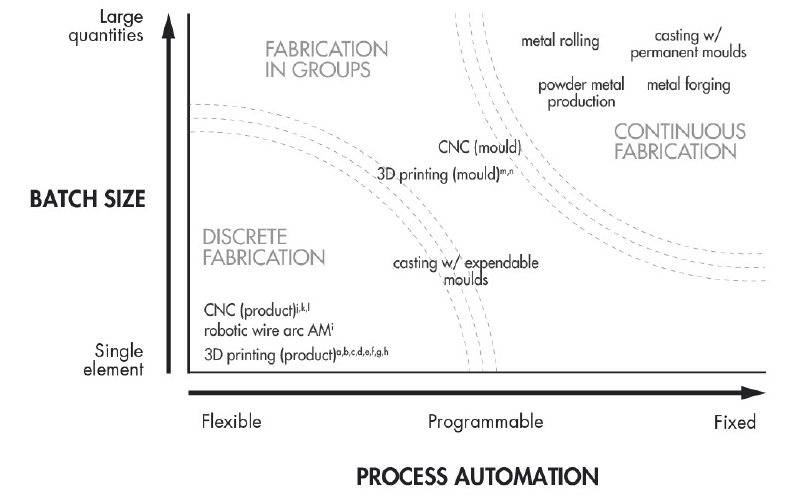
Figure 2. Classification of joint fabrication processes depending on batch size and process automation, and literature examples for each (adapted form [6]). The boundaries between different fabrication types remain fluid and cannot be strictly defined. (a) Hubs [36], (b) Chun et al. 2018 [37], (c) Dritsas et al. 2017 [38], (d) Souza et al., 2018 [39], (e) Tanadini et al., 2022 [40], (f) Kladeftira et al. 2021 [41], (g) Kladeftira et al., 2022 [42], (h) Bach et al., 2023 [43], (i) Ariza et al. 2018 [44], (j) LANIK Engi- neers [45], (k) MERO [46], (l) Octatube [47], (m) Niehe 2017 [35], (n) Aghaei Meibodi et al., 2019